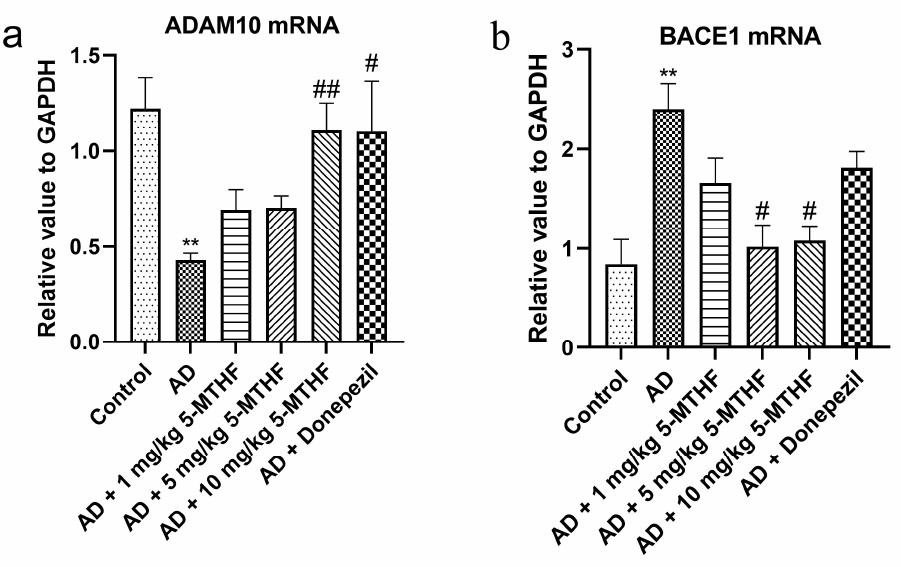
Figure 7. Effects of 5-MTHF on the expression of ADAM10 and BACE1 mRNA in the hippocampus of AD rats. ( a ) ADAM10 mRNA and ( b ) BACE1 mRNA. Data are shown as mean ± SEM. ** p < 0.01 compared with controls. # p < 0.05, ## p < 0.01 compared with the model group.